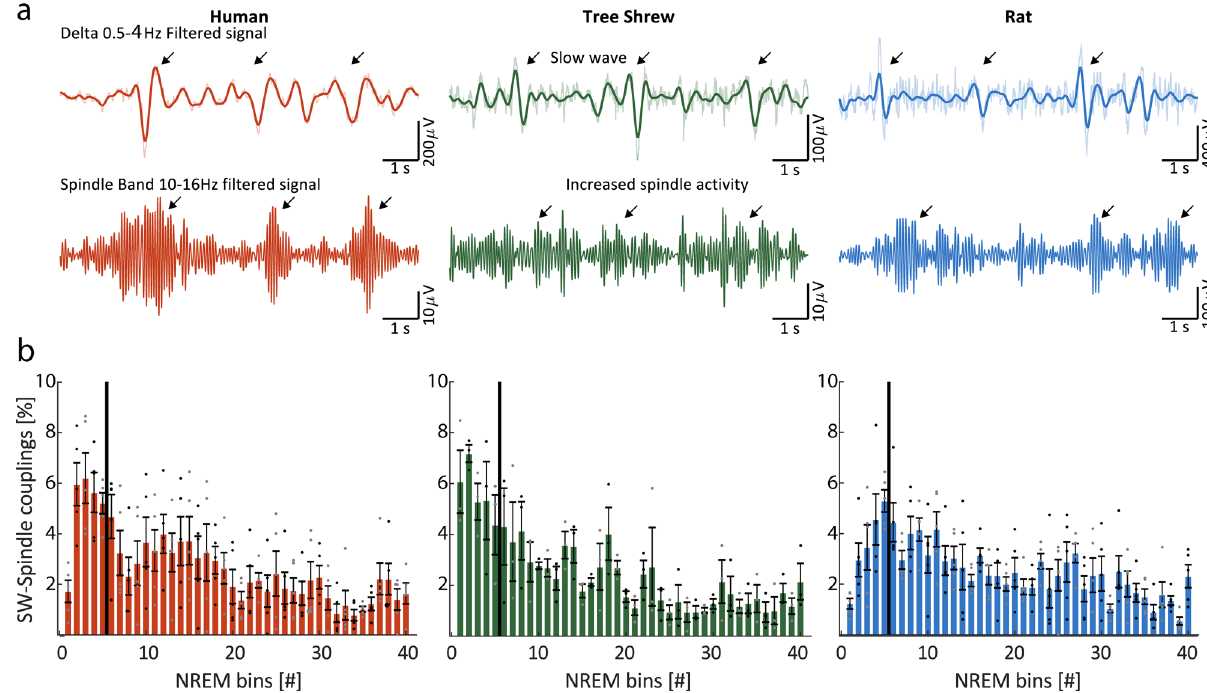
Fig. 5 Slow wave and sleep spindle analyses. a Example traces of NREM for the different species showing both slow waves and spindle band activity. Top row, signal fi ltered in the delta range (0.5 – 4 Hz) superimposed upon the wideband, shaded area, (0.5 – 45 Hz) signal. Arrows denote slow wave events. Bottom row, the same signal, but fi ltered in the spindle range (10 – 16 Hz), with arrows indicating spindle events. Note the co-occurrence of slow waves and bursts of spindle band activity. b Group averaged distribution of the coupling event across species, rats n = 5, tree shrews n = 4, humans n = 5. Histograms show the group average distribution of slow wave-spindle coupling events in percentages over the time course of NREM sleep divided in 40 bins per recording (error bars indicate ±SEM). Note the black line represents the section of the fi rst fi ve bins containing coupling events during the beginning of the sleep period that were used for statistical comparison. Error bars re fl ect the standard error of the